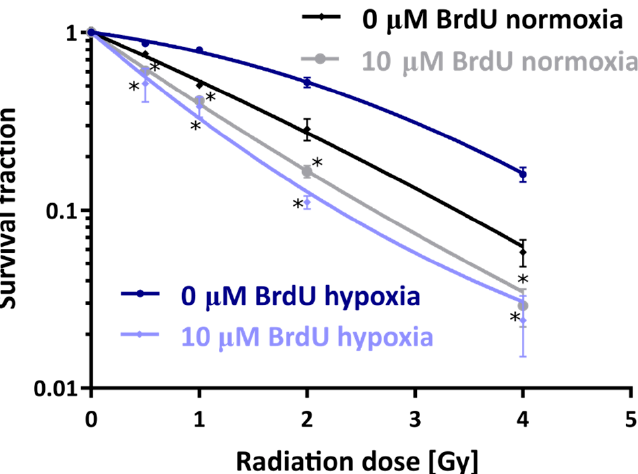
Figure 3. Dose–response curves for PC3 prostate cancer cells not treated or treated with BrdU (10 µM) under normoxia and hypoxia. Experiments were performed at least in duplicate, and the results are expressed as mean ± standard deviation. * Significant difference compared with the untreated variants, p < 0.05.